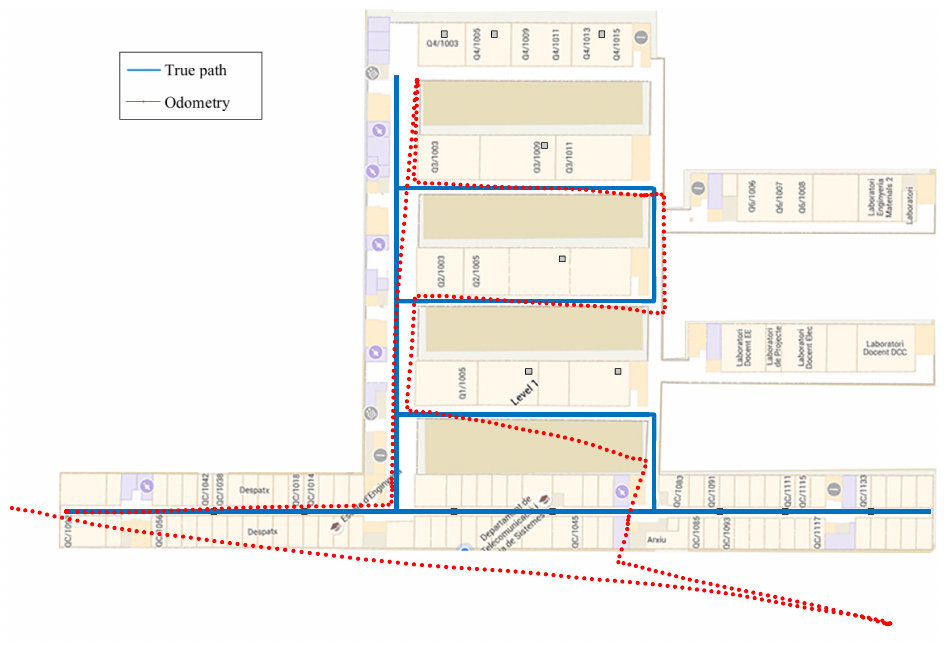
Figure 5. Path 1 and odometry obtained with the pocket navigation system.